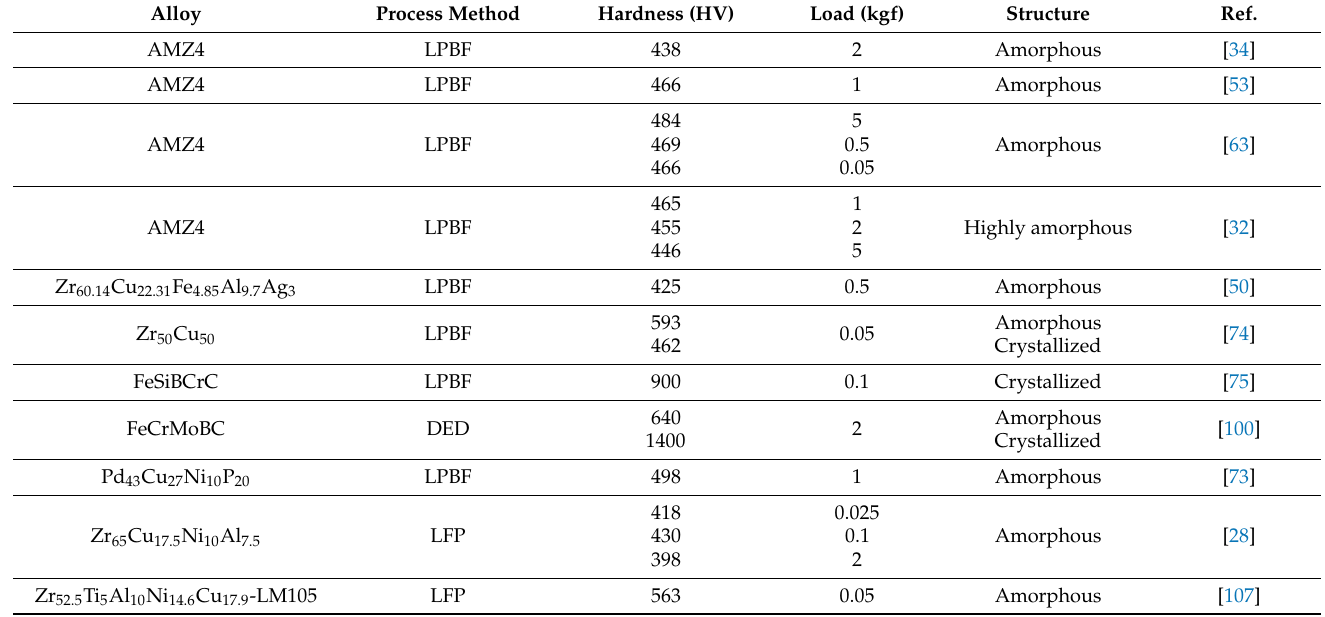
Table 3. Microhardness results of BMGs fabricated via AM